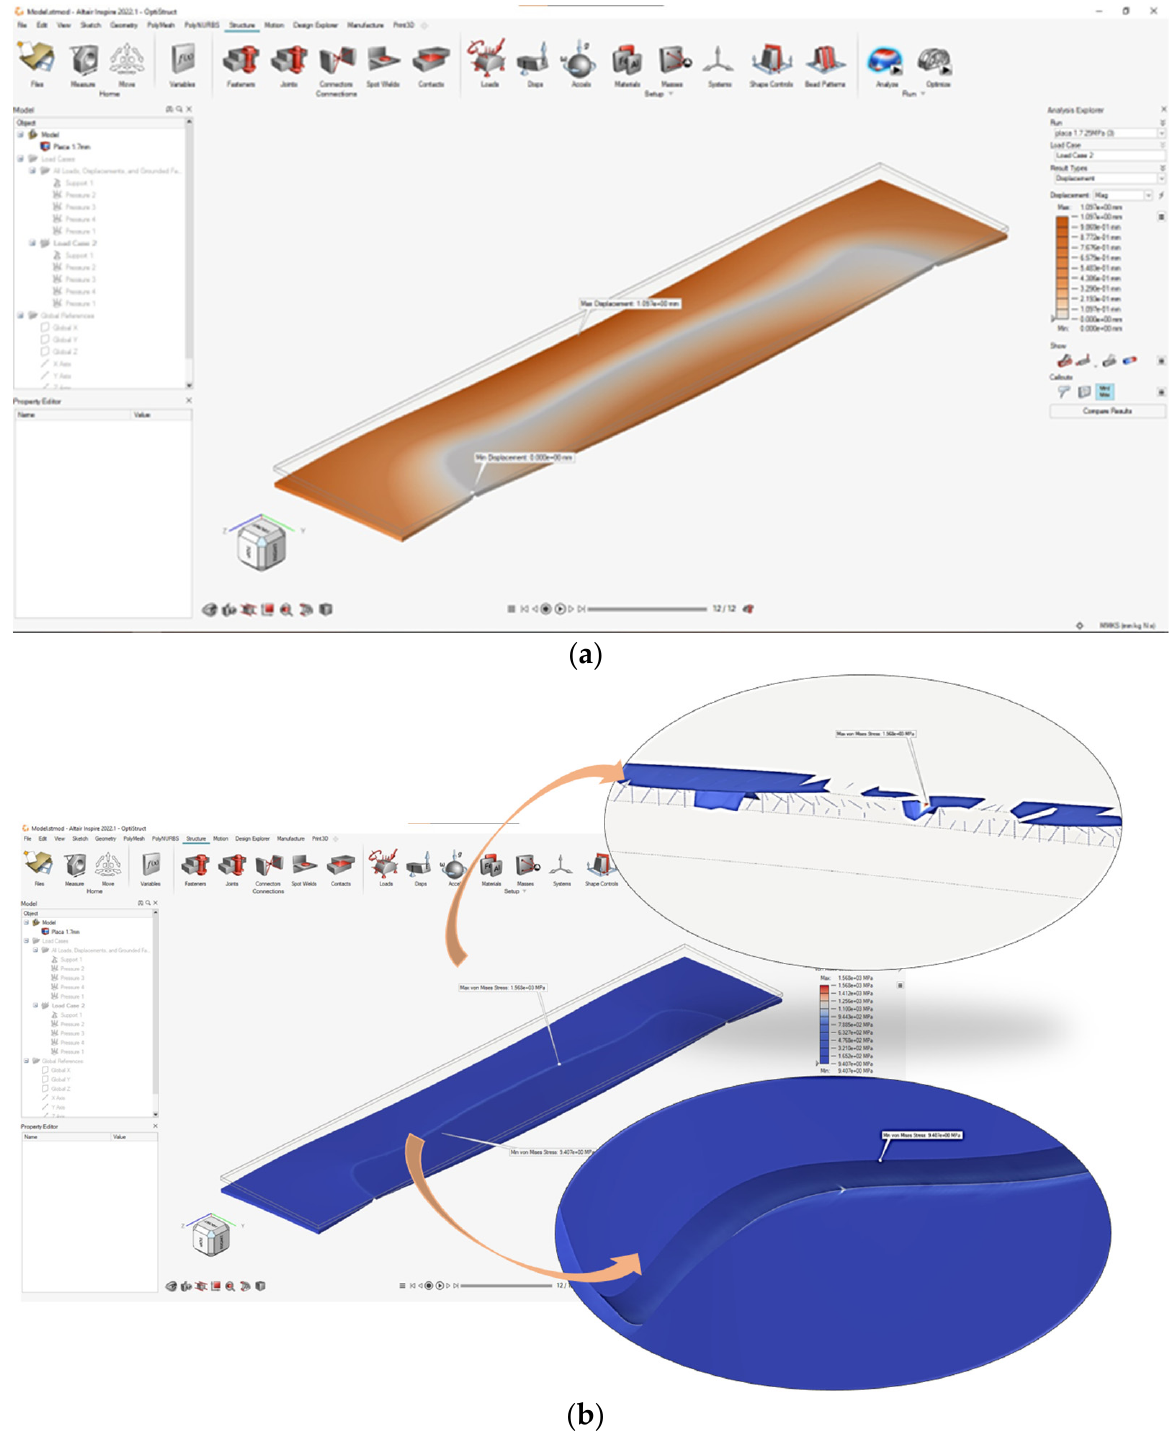
Figure 30. The model no. 1: ( a ) deformations; ( b ) von Mises equivalent stresses.